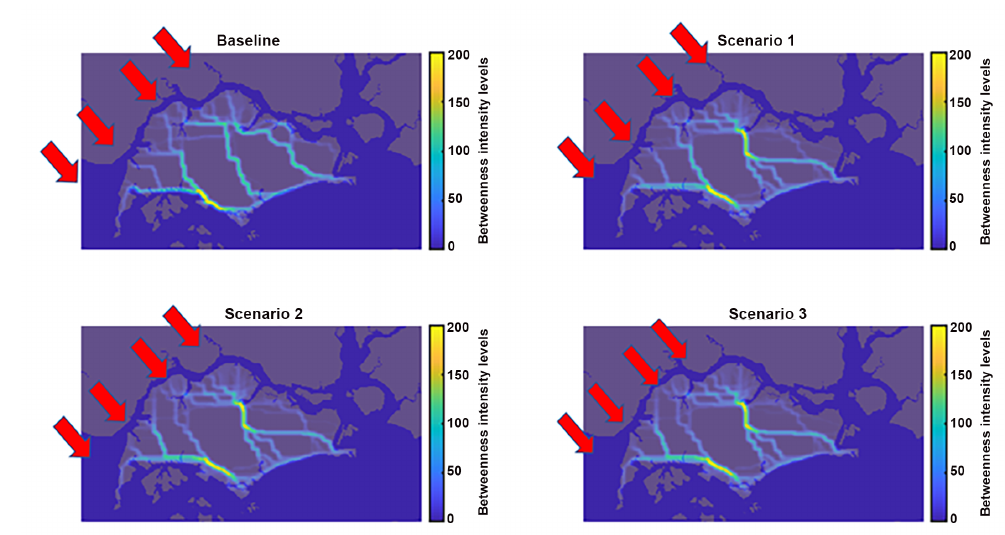
Figure 15. “What-if” scenario: The prevailing wind is Northwest–Southeast, ( θ A = π /8), indicated by the red